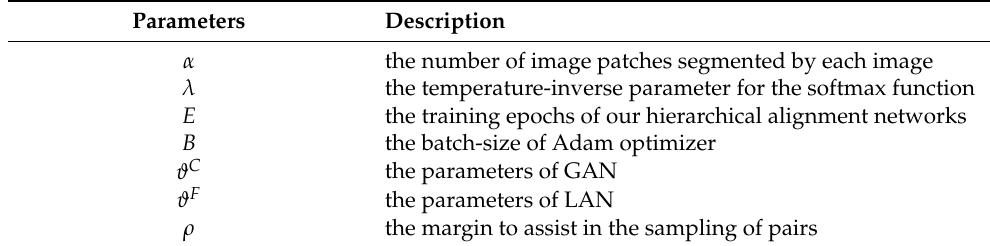
Table 2. Simulation parameters and